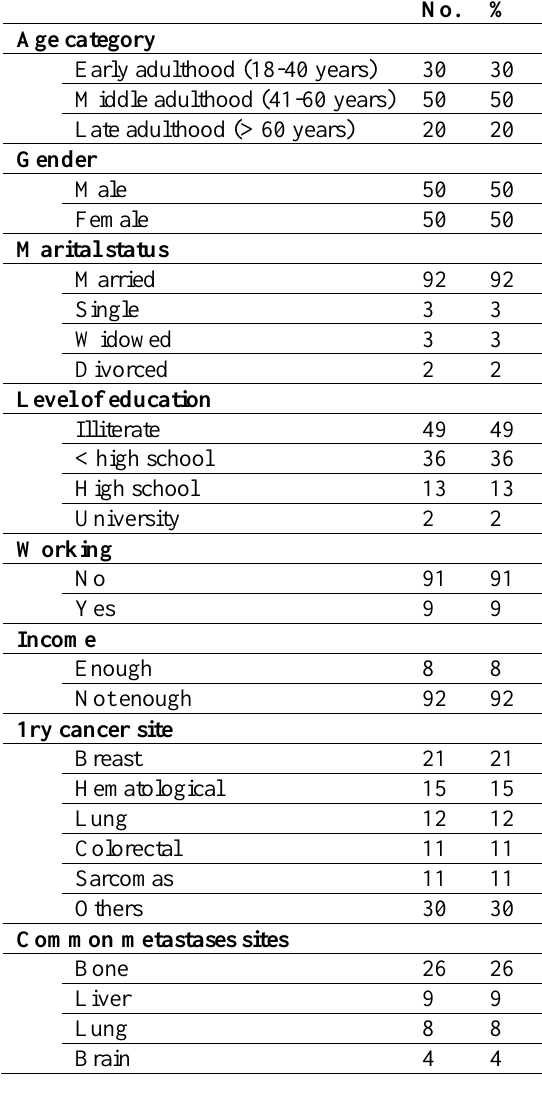
Table 1: Patients’ characteristics (n=100)